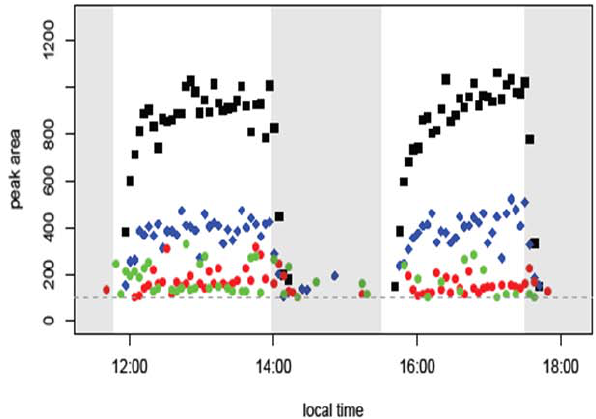
Fig. 7. Emissions of the potted Q. ilex , measured in the cuvette with sample times of 3min at 40 ◦ C sensor temperature of the zNose. The dashed line indicates the peak detection limit. i KI 988, m KI 1031, Y KI 1207, Y KI 1612. Fig. 10. Limonene calculated gas exchange rates for the zNose data (m), KI 1031 compared to rates obtained by solid sorbent GC-FID data ( m). The dashed line indicates the peak detection limit of zNose.